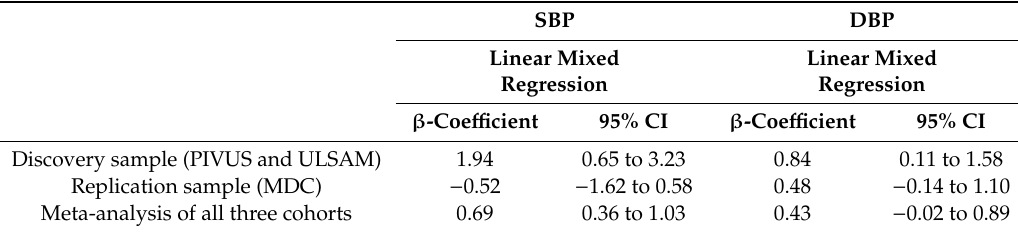
Table 3. Associations of renin at baseline with blood pressure change between baseline and